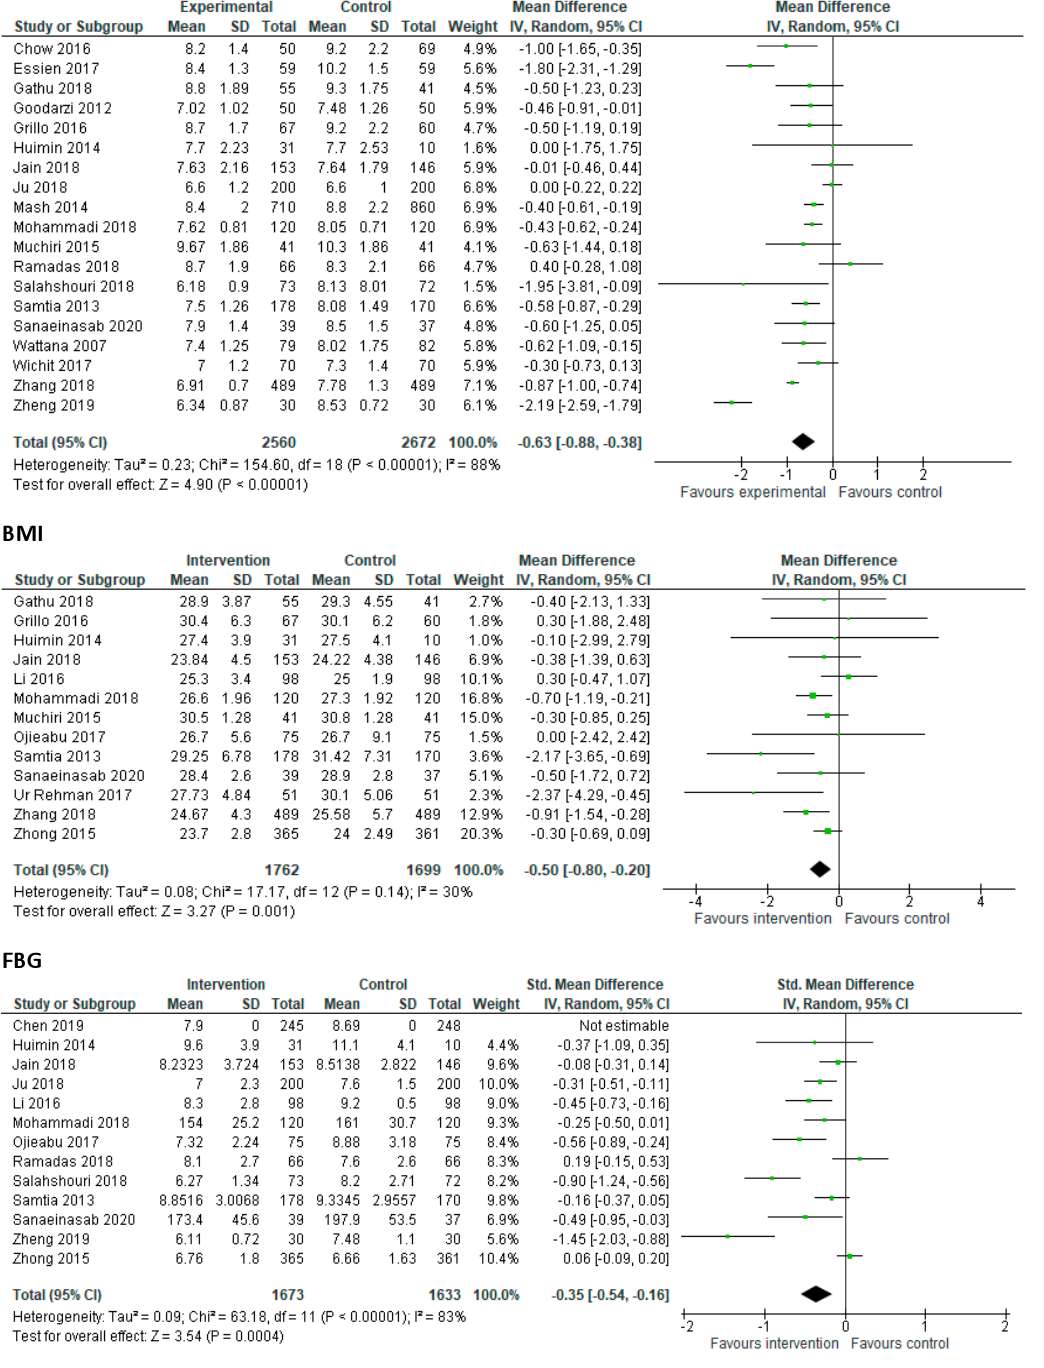
Figure 2. Forest plots illustrating group data from meta-analysis of HbA1c, FBG and BMI.